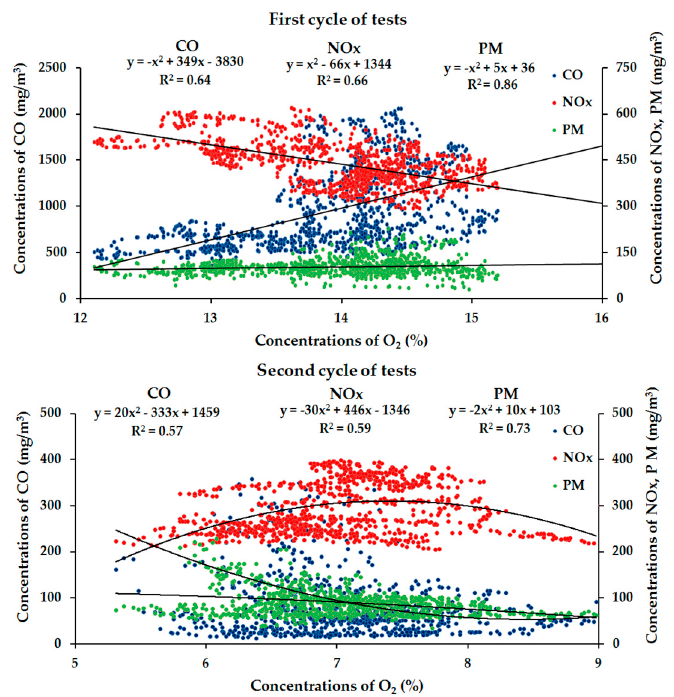
Figure 5. Mass distribution of harmful substances to the remaining oxygen for the first and second cycle of tests.